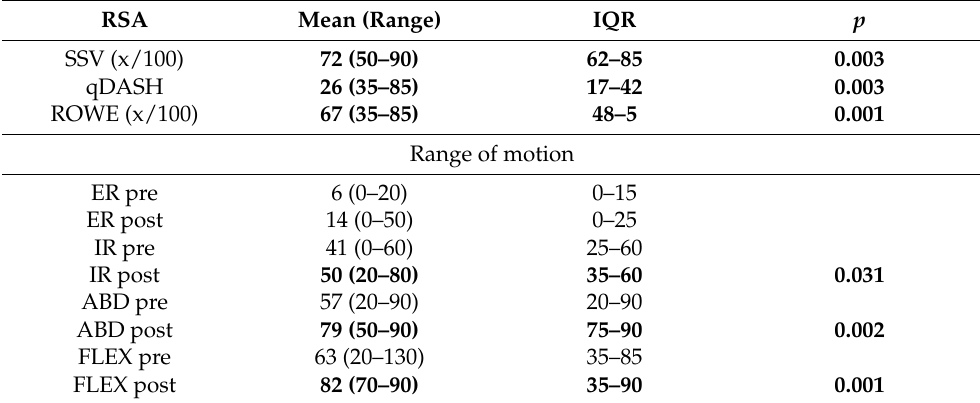
Table 5. Postoperative scores after second step of prosthesis reimplantation and range of motion (ROM) prior to prosthesis explantation (pre) and after second step prosthesis reimplantation (post) of patients revised to reverse shoulder arthroplasty (RSA). Values marked in bold show a statistically significant superiority of RSA over the large-head HA and megaprostheses. Empty cells mean lack of significance. IQR: interquartile range, ER: external rotation, IR: internal rotation, ABD: abduction, FLEX: forward flexion, HA CTA: hemiarthroplasty with CTA head (large head), SSV: subjective shoulder value, qDASH: “quick” Disabilities of the Arm, Shoulder and Hand.